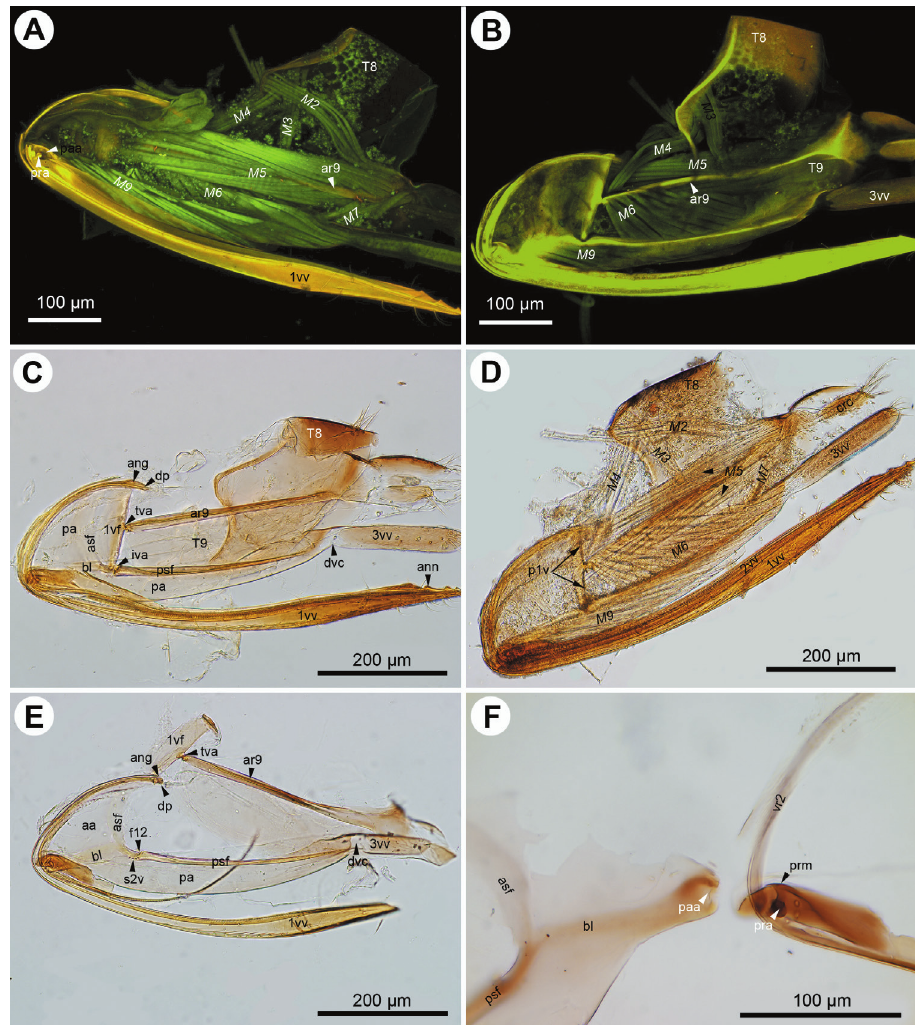
Figure 2. CLSM micrographs and bright field image showing the female terminalia of Conostigmus ab- dominalis (Boheman). A CLSM, medial view (doi: 10.6084/m9.figshare.156448) B CLSM, lateral view (doi: 10.6084/m9.figshare.156433) C bright field, medial view, muscles removed D bright field, medial view e bright field, medial view, first valvifer and T9 separated from second valvifer, muscles removed; F, bright field, second valvifer removed from second valvulae, muscles removed. All anterior to the left. number of annuli is four (ch41:0) in Conostigmus and Lagynodes and six (ch41:1) in Megaspilus